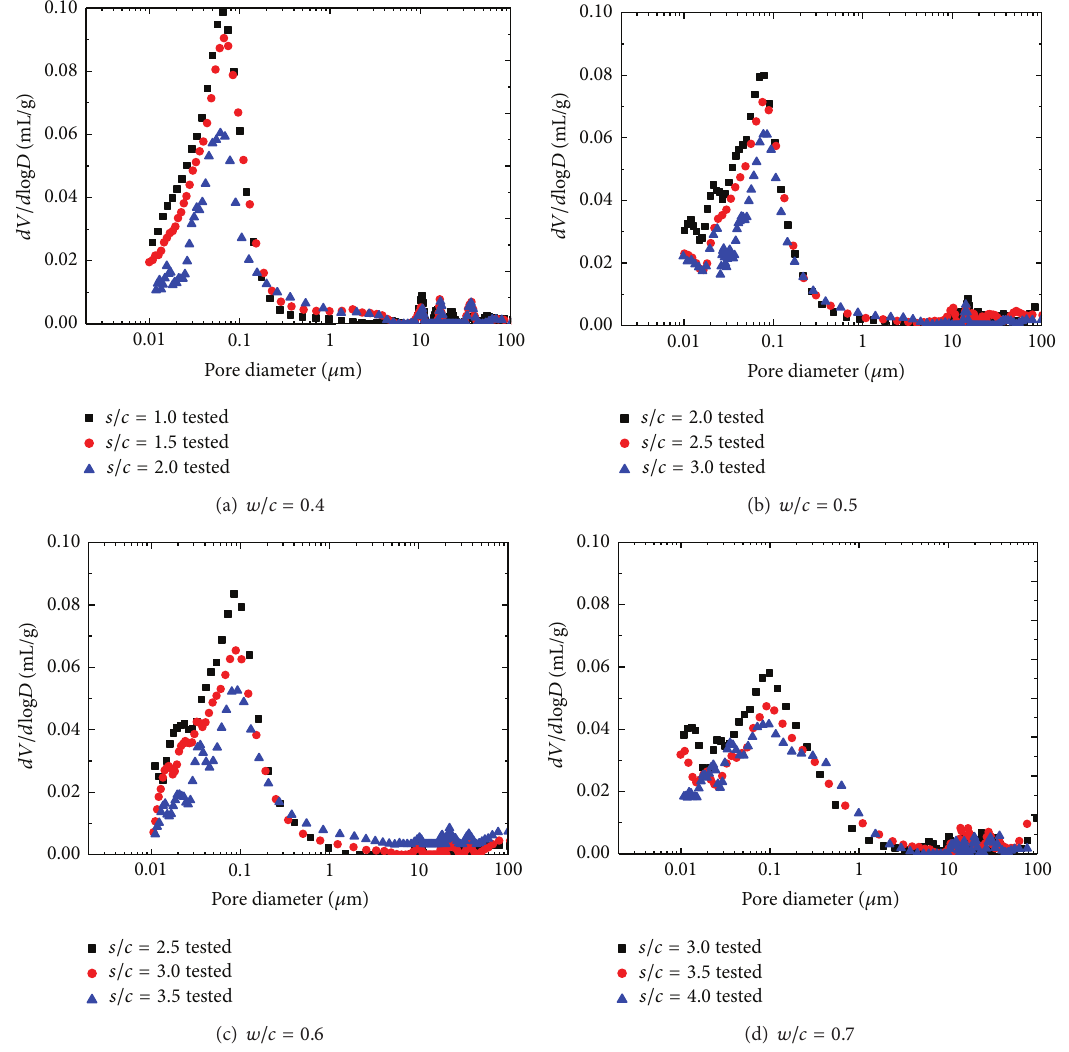
Figure 3: Differential intrudes volume versus pore diameter for MS mortars.